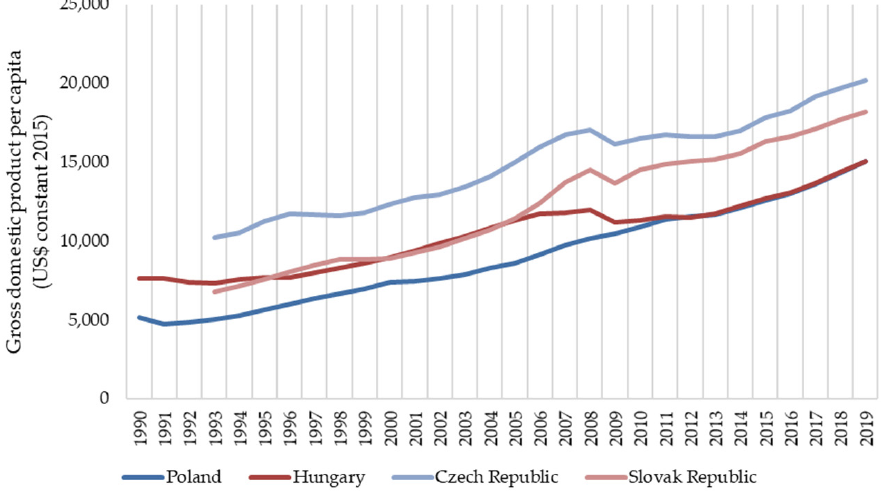
Figure 2. A plot of GDP per capita for V4 countries in 1990–2019 (in USD constant 2015). Source: OECD database.